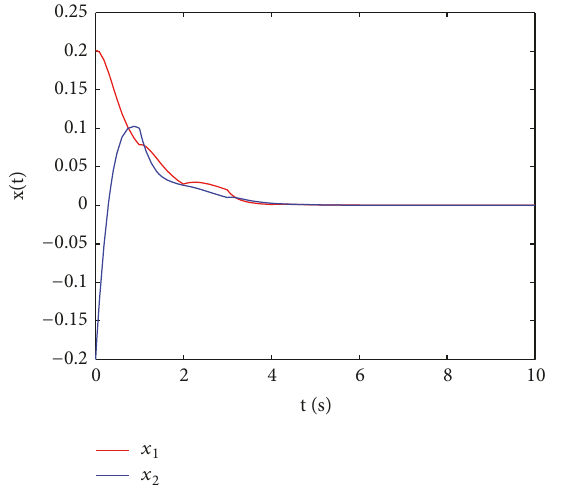
Figure 3: The state trajectories of system (1) with 𝜏(𝑡) = 0.1 + 0.05 sin 𝑡 .